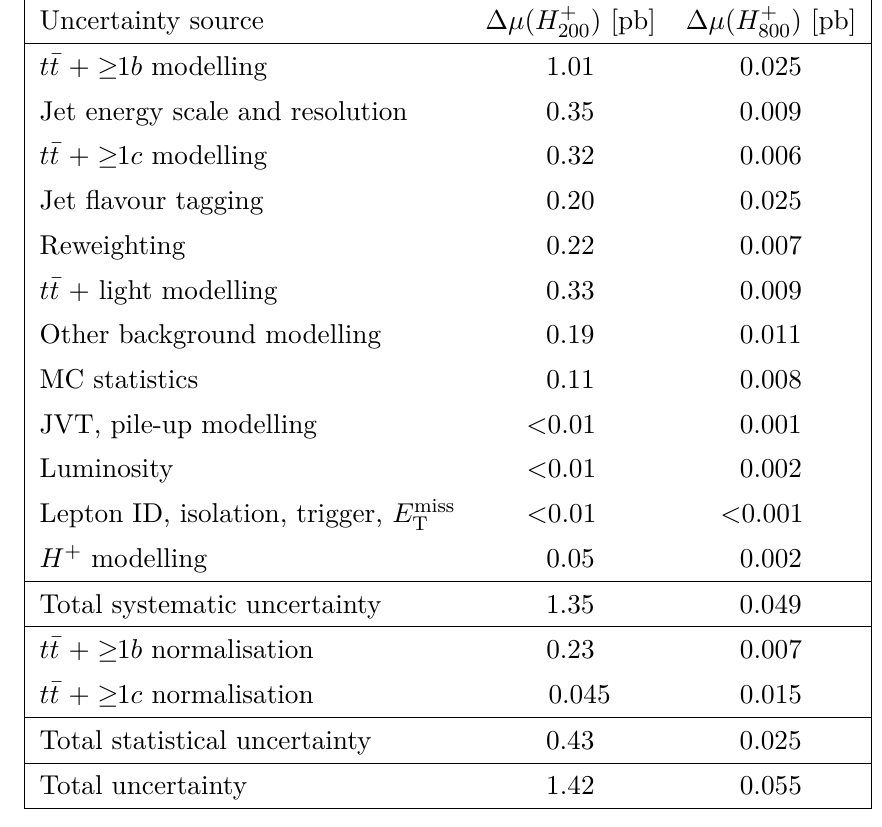
Table 3 . Summary of the statistical and systematic uncertainties on µ = σ ( pp → tbH + ) ×B ( H + → tb ) shown for a H + signal with a mass of 200 and 800 GeV, extracted from the fit to the data. A value of µ = 1 pb is assumed for all H + mass hypotheses. Due to correlations between the different sources of uncertainty, the total systematic uncertainty can be different from the sum in quadrature of the individual sources. The normalisation factors for both t ¯ t + ≥ 1 b and t ¯ t + ≥ 1 c are included in the statistical